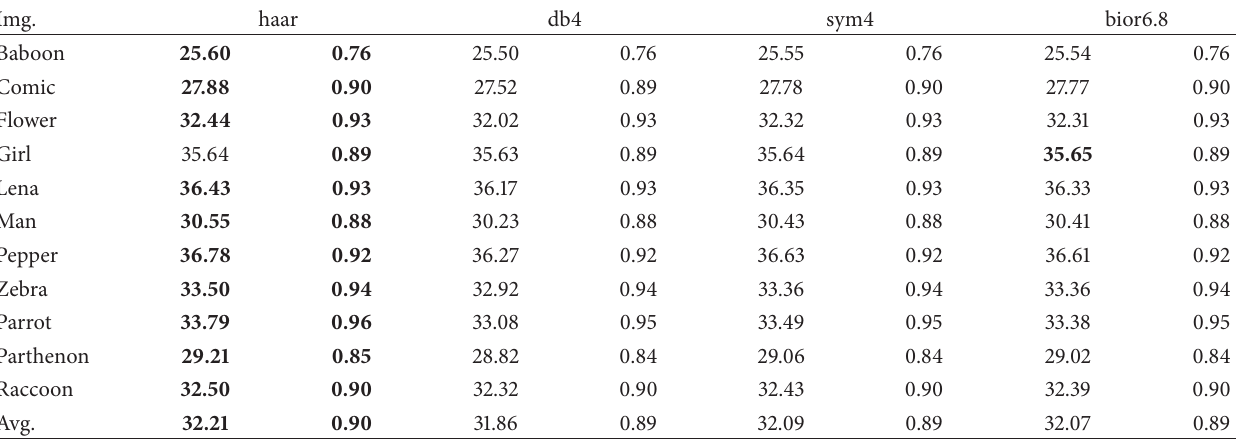
Table 1: The PSNR and SSIM values of the proposed method with different wavelet-filters (for each wavelet, the left is PSNR values and the right is SSIM values).